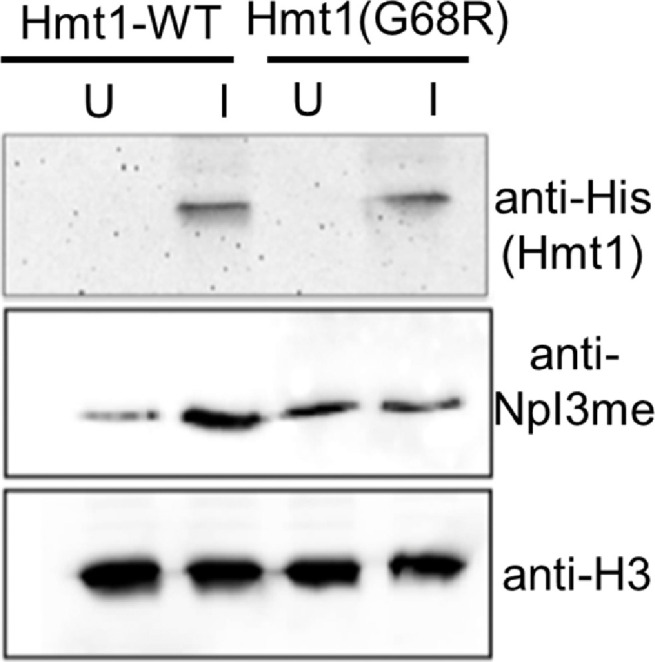
Validation of overexpression of exogenous proteins from constructs and verification of reduced methylase activity of Hmt1(G68R). Immunoblot analysis of extracts isolated from strains grown in uninduced (U = glucose) and induced (I =galactose) conditions, to confirm overexpression for Hmt1 wild-type and catalytically mutant Hmt1(G68R). Overexpression of WT Hmt1-HZ in induced conditions results in increased methylated levels of its known substrate NpI3. Upon overexpression of Hmt1(G68R)-HZ, the methylation levels of NpI3 are unchanged between uninduced and induced conditions. The detected methylation of Npl3 in the Hmt1(G68R)-HZ strains is mediated by the endogenous wild-type Hmt1 enzyme. The levels of overexpressed Hmt1 were detected using an anti-His antibody recognizing the HZ tag and of its substrate Npl3 was detected using an anti-Npl3 methylated antibody. The loading of protein extracts was monitored by an anti-histone H3 antibody.